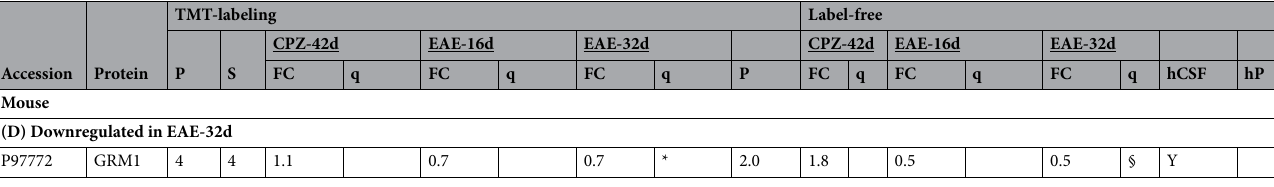
Table 3. Significantly regulated proteins in both TMT-labeling and label-free. (A) Proteins upregulated in CPZ-42d in both TMT and label-free. (B) Proteins downregulated in CPZ-42d in both TMT and label-free. (C) Proteins upregulated in EAE-16d in both TMT and label-free. (D) Protein downregulated in EAE-32d in both TMT and label-free. For all tables: quantified proteins, number of unique peptides (P) and spectra (S) with fold change relative to respective controls (FC) are shown for CPZ-42d, EAE-16d and EAE-32d. The p-values for the regulated proteins were corrected for multiple hypothesis testing to control false discovery rates, resulting in adjusted p-values (q-values). The q-values are denoted in the table as follows: §, q < 0.1; *, q < 0.05; *’ q < 0.01; **, q < 0.005, *** q < 0.0005. For the TMT-data, the z-scores for all the protein ratios in each condition were calculated using a Gaussian probability function, and the p-values corrected using Benjamini– Hochberg (q-values), as previously described 11 . For the label-free data Progenesis LC–MS was used to calculate statistically up- and downregulated proteins based on ANOVA (p-value) with correction for multiple hypotheses testing based on FDR (q-value). Consistent regulation in all individuals in CPZ-42d allowed a stringent limit for the corrected p-value from multiple hypothesis testing (q < 0.05), a moderate in in EAE-16d (q < 0.051) and a higher limit in EAE-32d (q ≤ 0.1). Human orthologues present in human cerebrospinal fluid (hCSF) and plasma (hP) according to the CSF-PR database 21 are indicated with yes (Y =